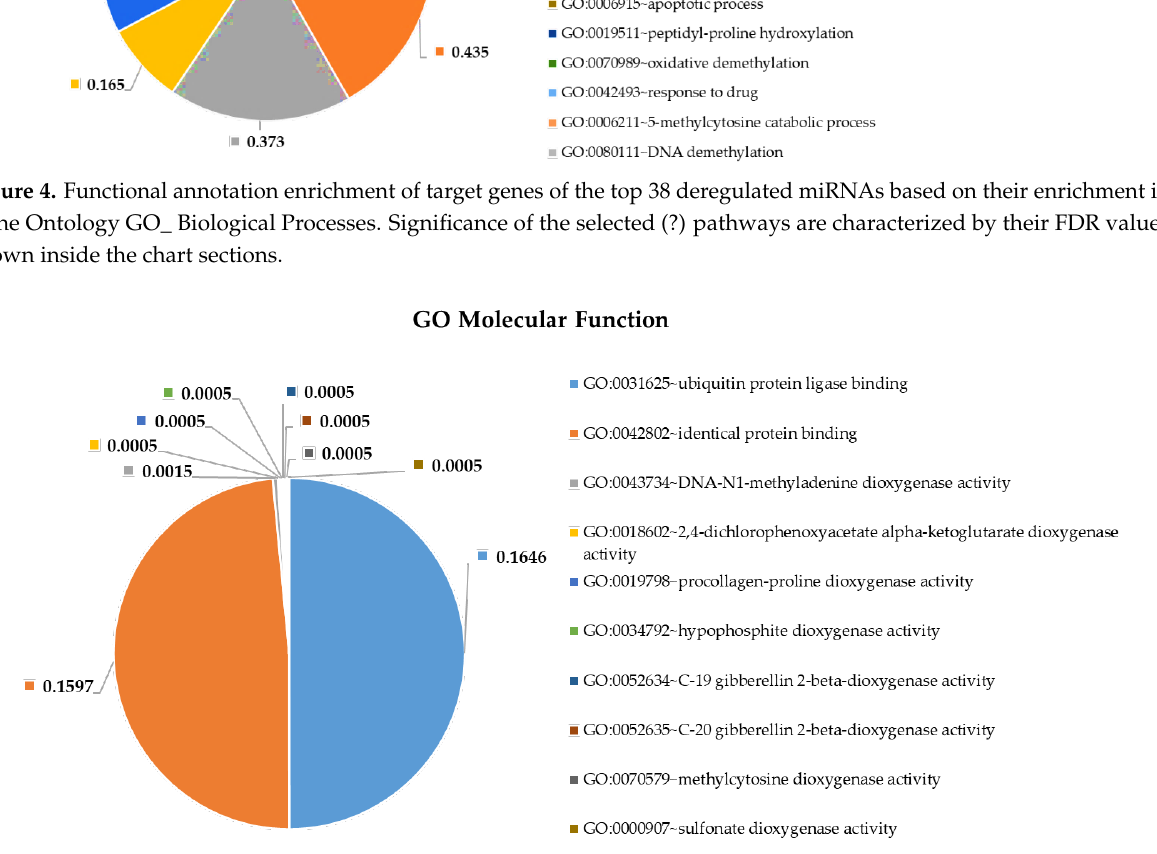
Figure 5. Functional annotation enrichment of target genes of the top 38 deregulated miRNAs based on their enrichment in Gene Ontology GO_ Molecular Function. Significance of the selected (?) pathways are characterized by their FDR values shown inside the chart